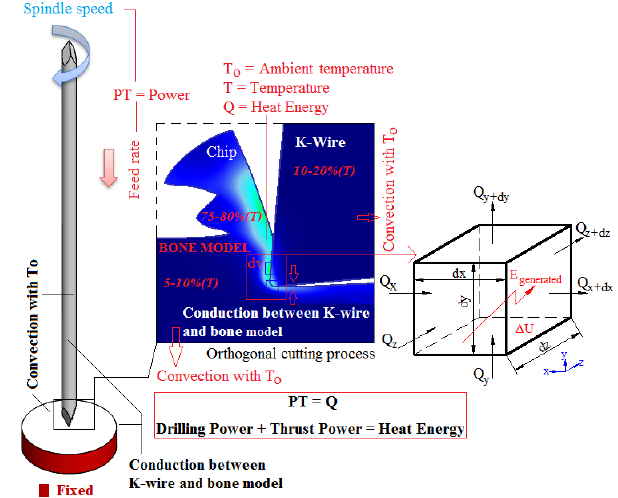
Figure 3. Thermal model of the drilling process using K-wire.